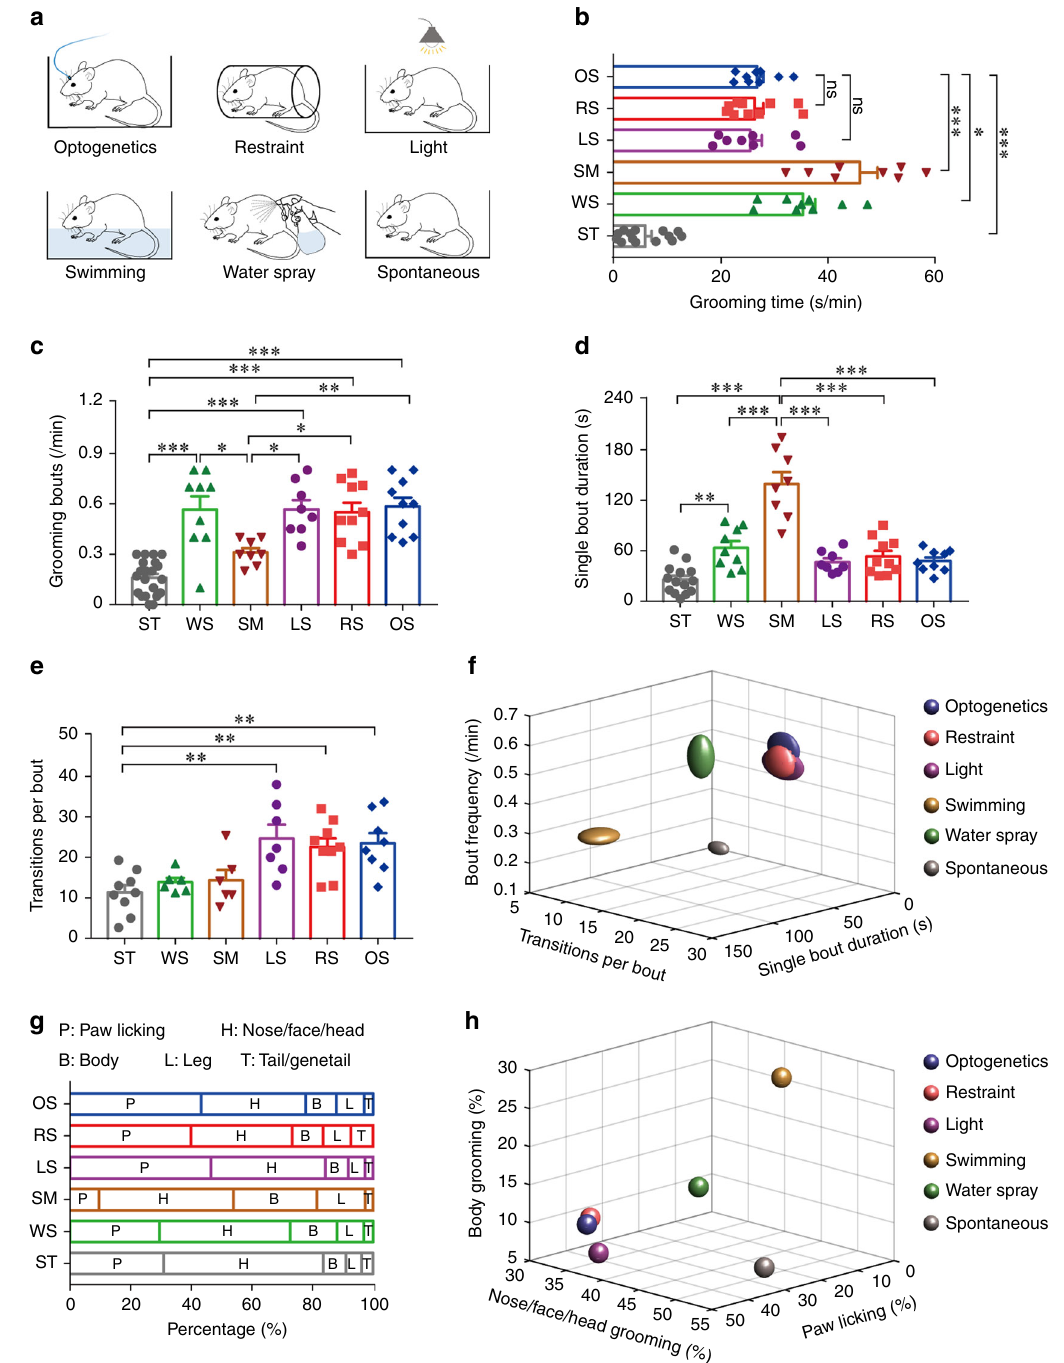
Fig. 5 Grooming induced by optogenetic activation of the VS → LSv → Tu circuitry resembles emotional stress-induced grooming. a The six grooming models in this study, including optogenetic activation of LSv (OS), body restriant (RS), light exposure (LS), swimming (SM), water spray (WS) and spontaneously occurring (ST). b The OS-induced ( n = 9), RS-induced ( n = 10) and LS-induced ( n = 8) grooming models spent similar average time in this behaviour but were signi fi cantly lower than that in SM-induced ( n = 8) and WS-induced ( n = 9) models. n = 14 for ST model (one-way ANOVA with Tukey post-hoc test; ns: not signi fi cant; OS vs. ST, *** P < 0.0001; OS vs. WS, * P = 0.0387; OS vs. SM, *** P < 0.0001). c – e The grooming frequency (bouts per min, c ), single bout duration d and transitions per bout e were variable among the different models. One-way ANOVA with Tukey post-hoc test. * P < 0.05; ** P < 0.01; *** P < 0.001. f Optogenetics-induced grooming, the body restraint and light exposure models are highly similar in term of bout frequency, bout duration and transitions per bout. The dimension of the symbol along an axis is de fi ned by the SEM of the corresponding parameter. g The average number of times spent on grooming different body parts in the six experimental models of this study, expressed as % of total. h 3-D plot of the number of times spent in grooming different body parts revealed higher similarity of the optogenetics model and the restraint and light models. All data are presented as mean ± SEM. See also Supplementary Table 2 for further statistical information. Source data are provided as a Source Data fi